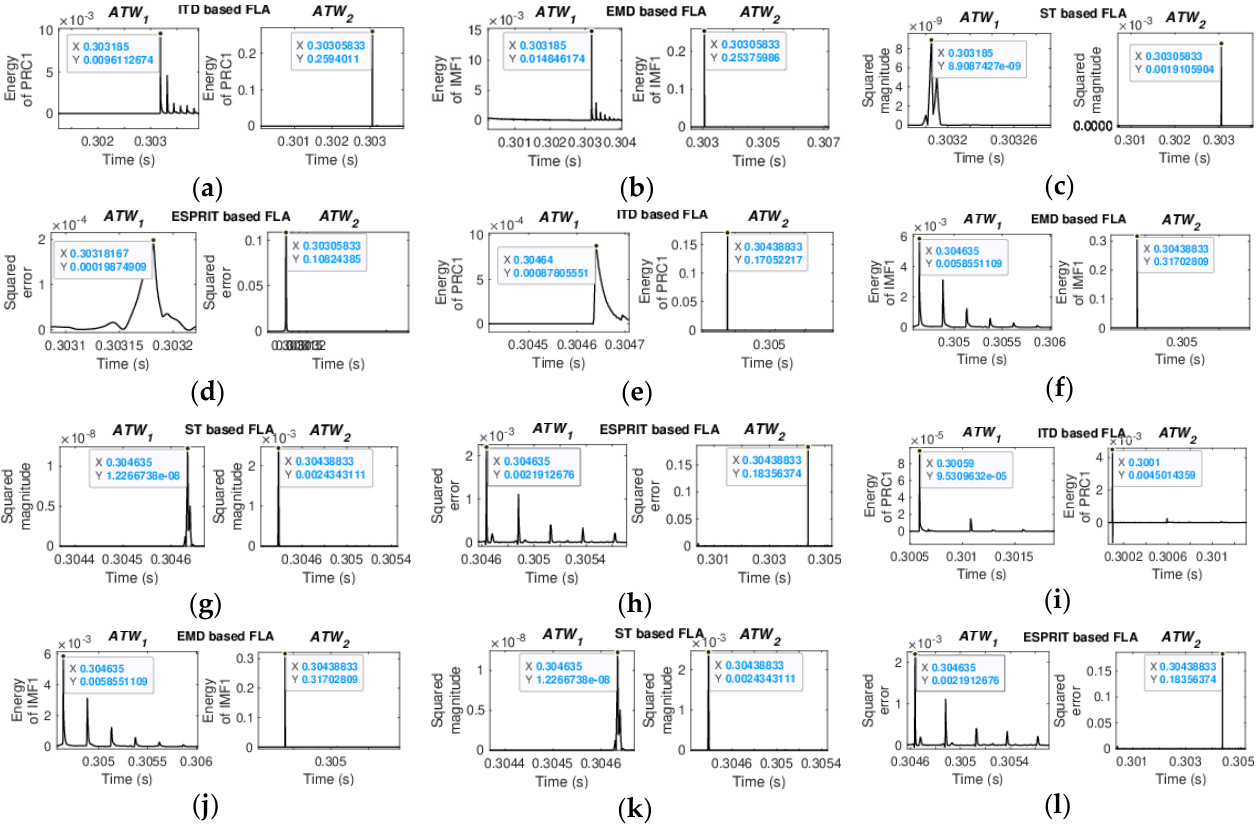
Figure 4. Estimation of ATWs for series-compensated systems for faults before SSSC. ( a – d ) Esti- mated ATWs for Scenario 1. ( e – h ) Estimated ATWs for Scenario 2.